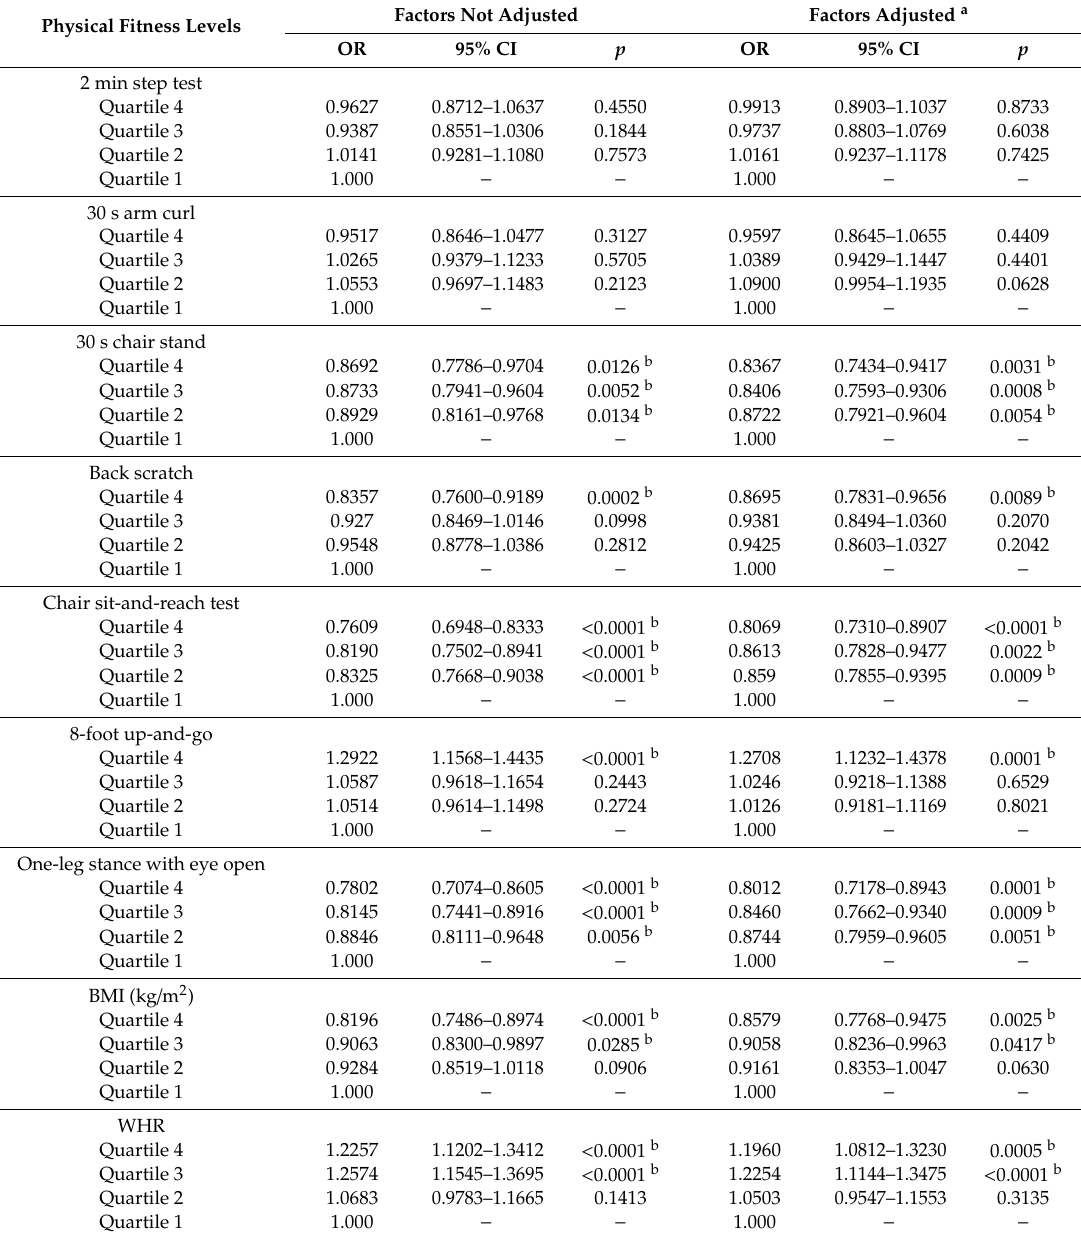
Table 4. Multivariate adjusted ORs for long sleep duration ( ≥ 8 h / day) in relation to each physical fitness measurement after adjustment for potential